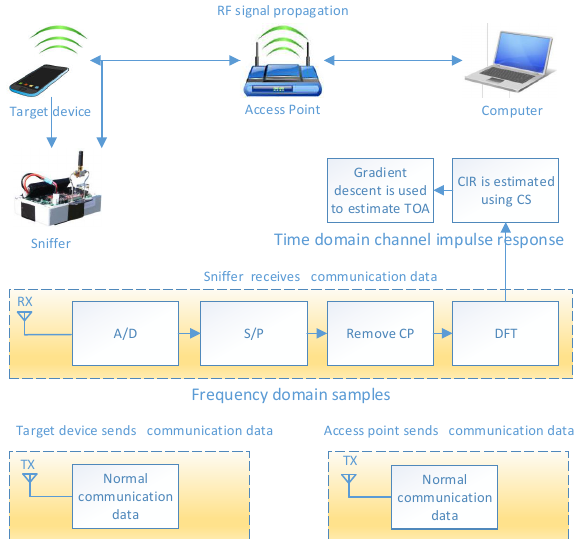
Figure 2. System model for the TOA computation in WiFi-WASP localization using